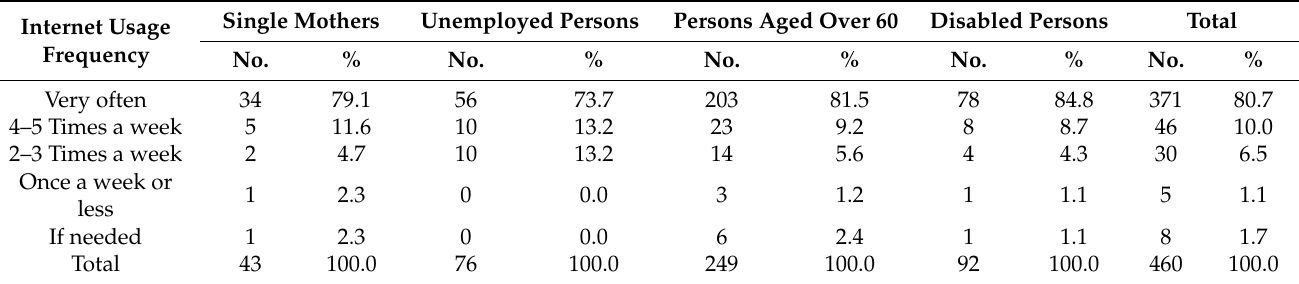
Table 10. Internet usage frequency by social status of the respondents ( n = 460).